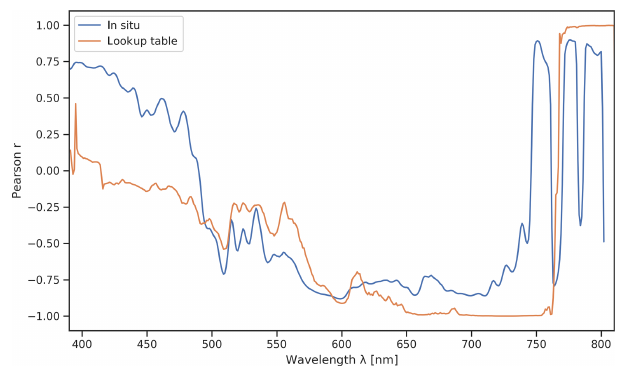
Figure 8. Wavelength-dependent correlation coefficients of pond depth with slope of log-scaled spectra for in situ measurements and simulated